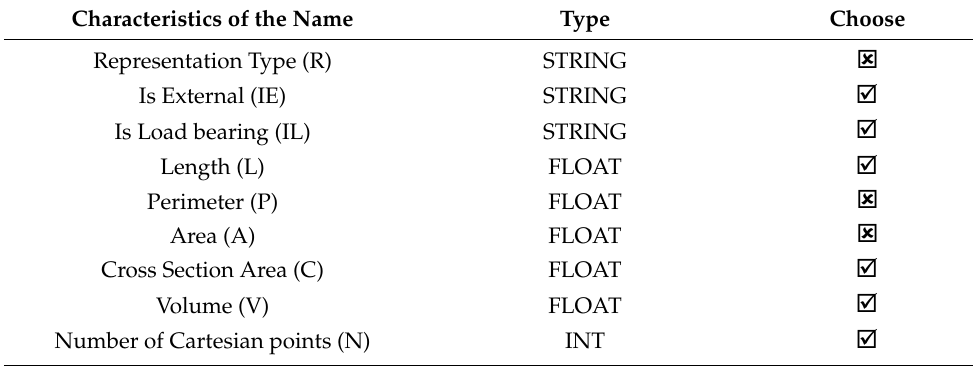
Figure 4. Relationship between model effect and number of features.